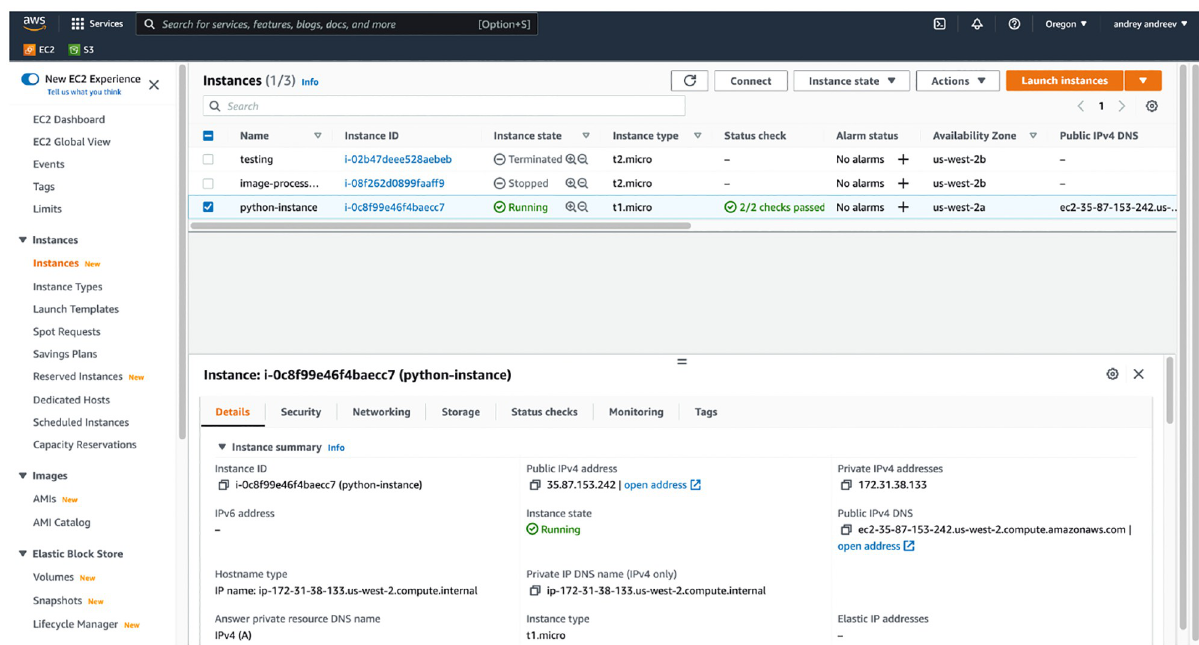
Fig 3. EC2 dashboard showing all launched, stopped, and recently terminated instances. Running instances are virtual machines, and you are being billed by the second whether you are connected to them or not. Stopped instances are billed for space required to store their memory and data. Stopped instances can be re-started, but state of the memory (RAM) is not guaranteed to be